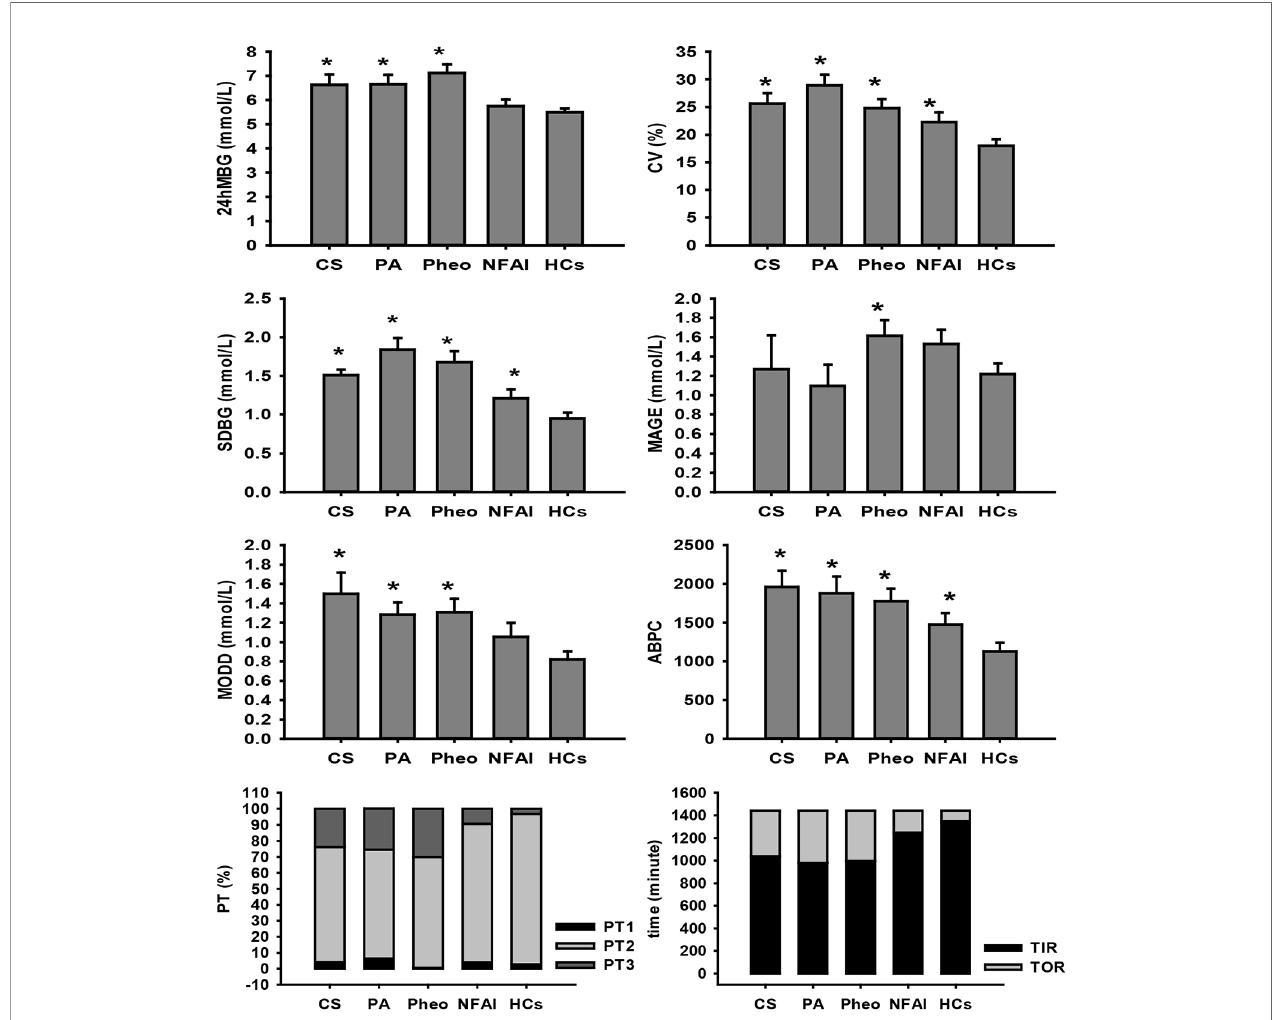
FIGURE 1 | Comparison of FGMS-related parameters in ADs and HCs. * represents signi fi cant difference between ADs and HCs. The data were showed as mean ± SEM. FGMS, fl ash glucose monitoring system; ADs, adrenal disease group; HCs, healthy controls; SEM, standard error of mean.